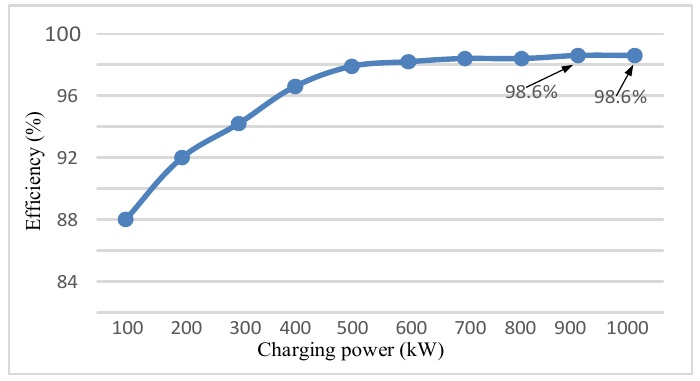
Figure 18. Efficiency of PCS under different load